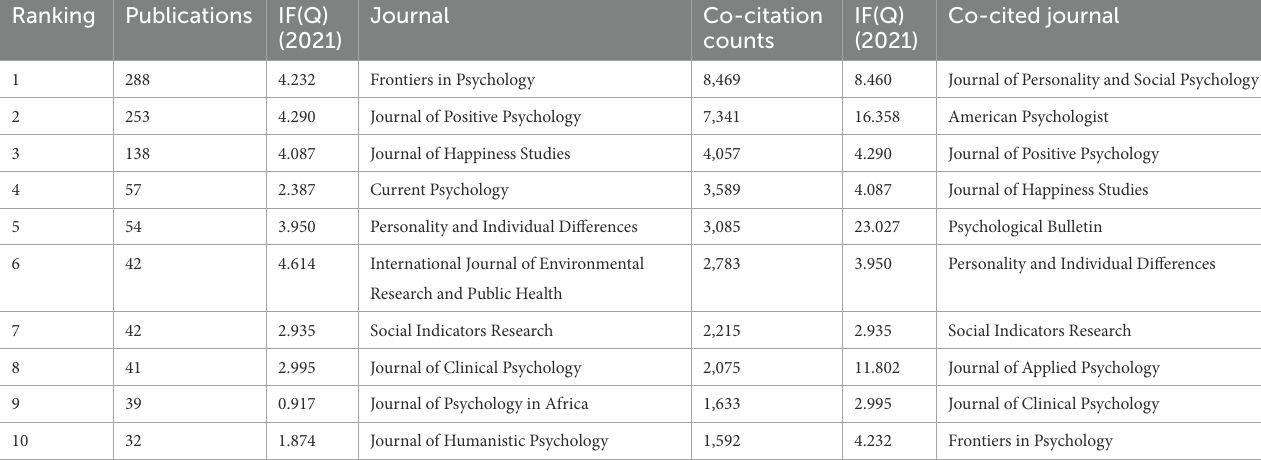
TABLE 3 Top 10 scholarly journals and co-cited journals in positive psychology research.